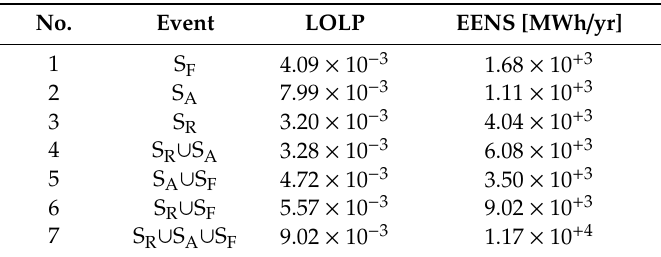
Table 4. Reliability result of different system states.